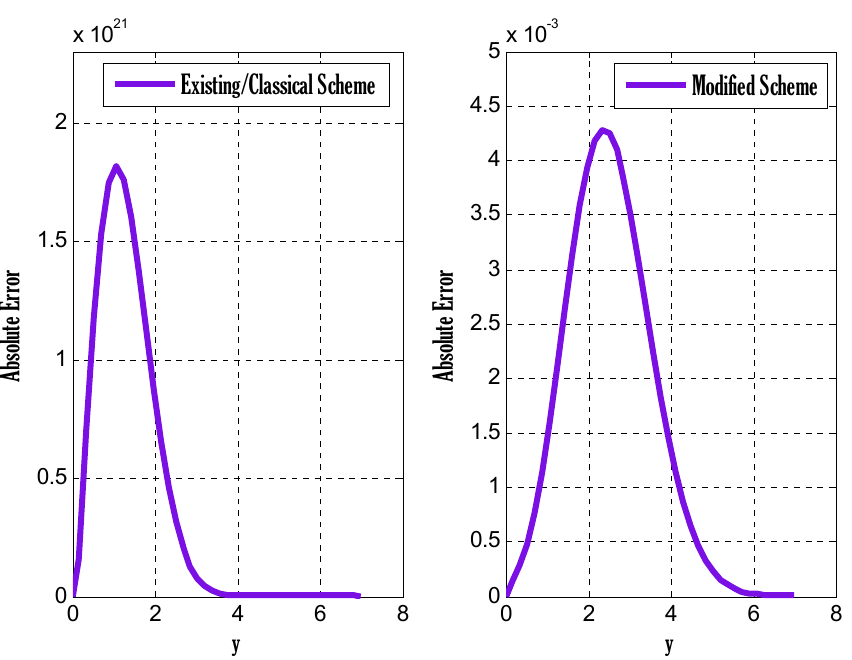
Figure 13. Comparison of existing/classical Adams–Bashforth scheme and proposed scheme using N t = 50, N y = 40, t f = 1 .